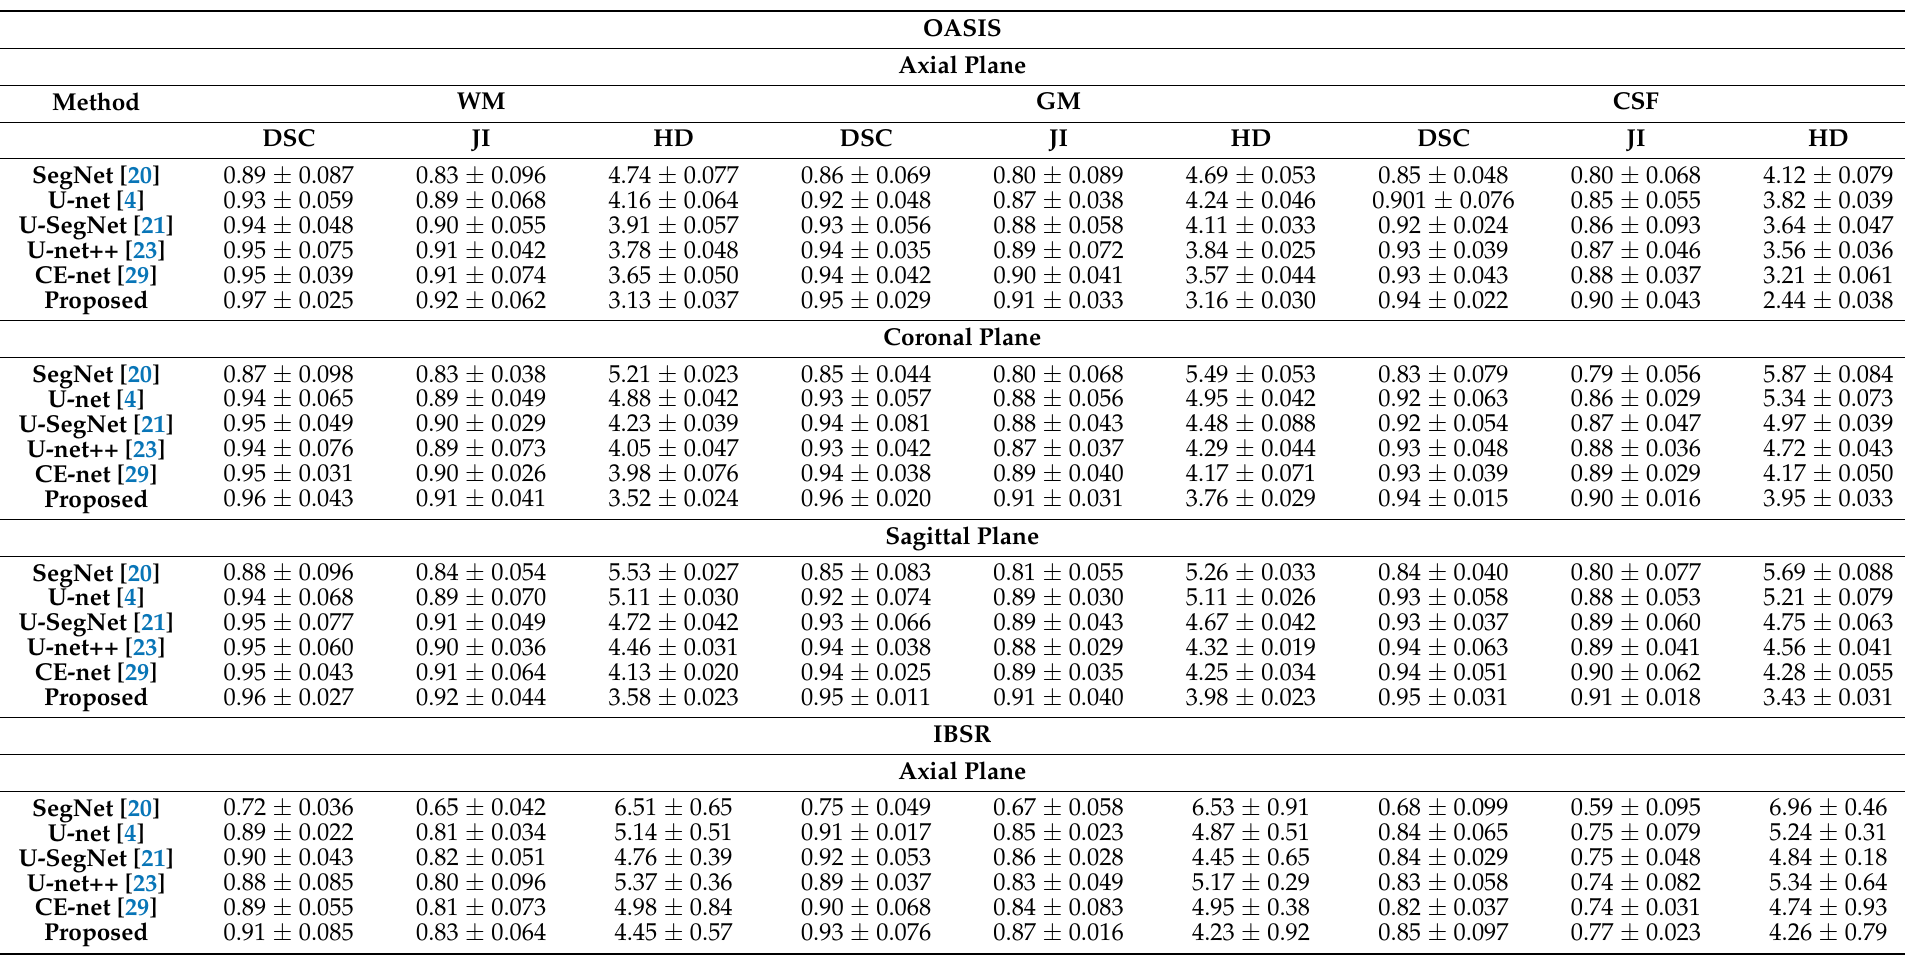
Table 3. Comparisons between the segmentation accuracy for the proposed method and conventional methods on OASIS and IBSR datasets.